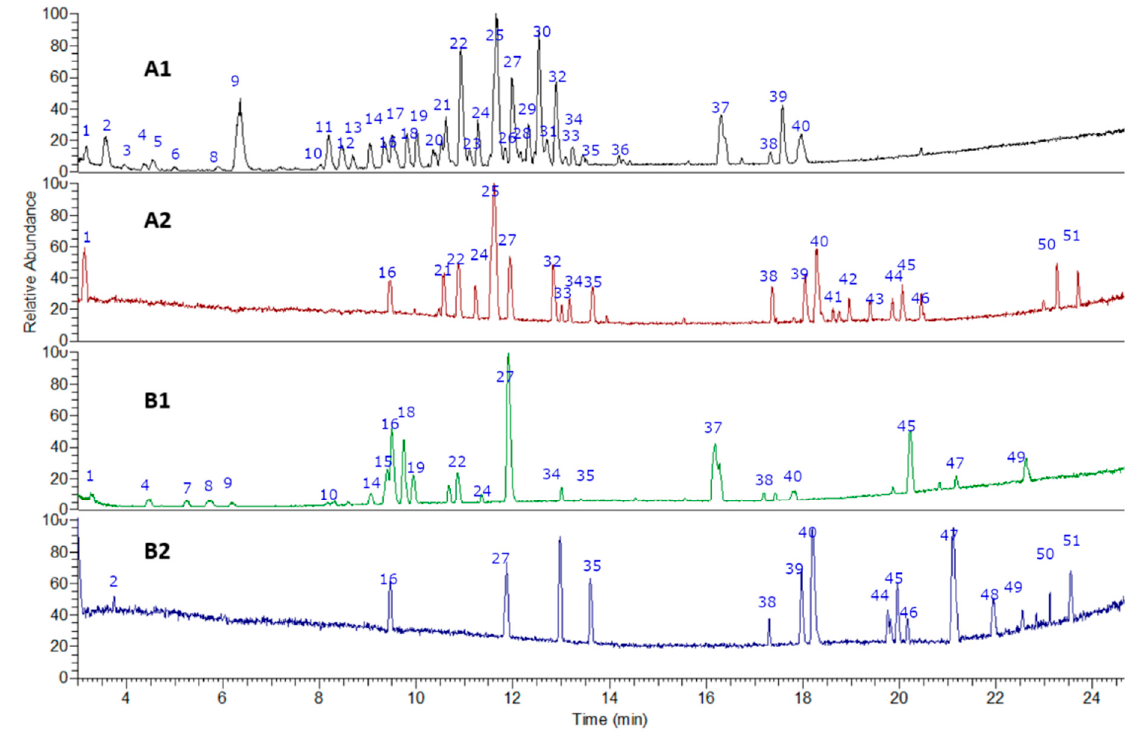
Figure 2. UHPLC–PDA–ESI–OT–MS/MS chromatograms (TIC, total ion current) of ( A1 ) pod husk flour negative mode, ( A2 ) pod husk flour positive mode, ( B1 ) vein flour negative mode, and ( B2 ) vein flour positive mode.